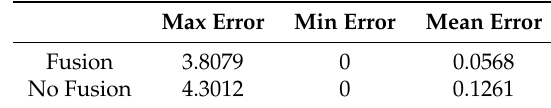
Table 4. The maximum, minimum and mean of distance error value of the integration and no